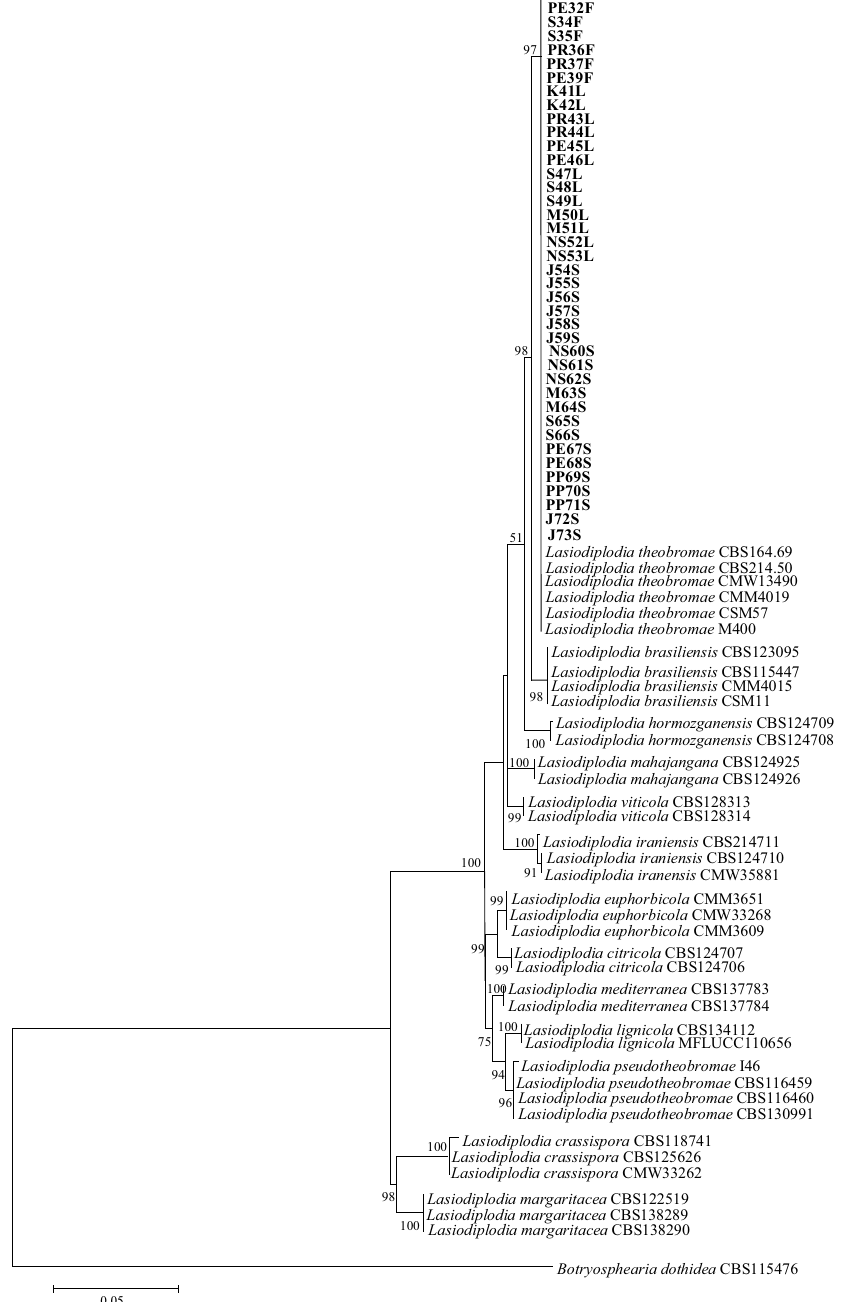
Figure 2. The maximum likelihood (ML) tree was generated with 1000 bootstrap replications using the Tamura-3-parameter model. The ML tree is inferred from concatenated sequence dataset of four genes (ITS, tef1-α tub2 , and rpb2 ). Bootstrap support values greater than 50% are pointed out at the nodes. Isolates in bold represent isolates in the present study and Botryosphearia dothidea represents the outgroup. The bar indicates the substitutions number per